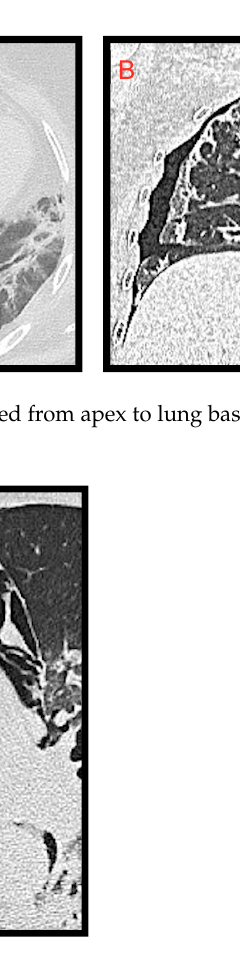
Figure 6. Axial CT image of a 70-year-old female patient. Gross parenchymal consolidation with central excavation suspected for superinfection is evident in the anterior segment of the right upper lobe. In addition, reinforcing suspicion of superinfection, the study was negative for pulmonary embolism.